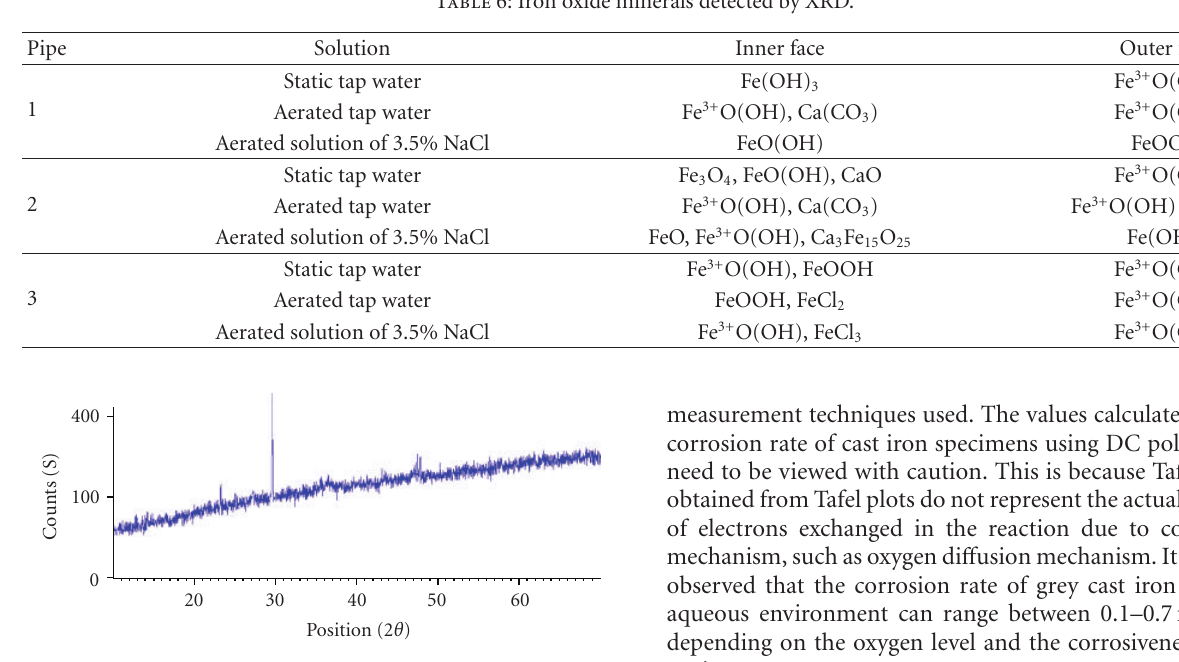
Figure 15: XRD from corrosion product of a specimen from Pipe 2.